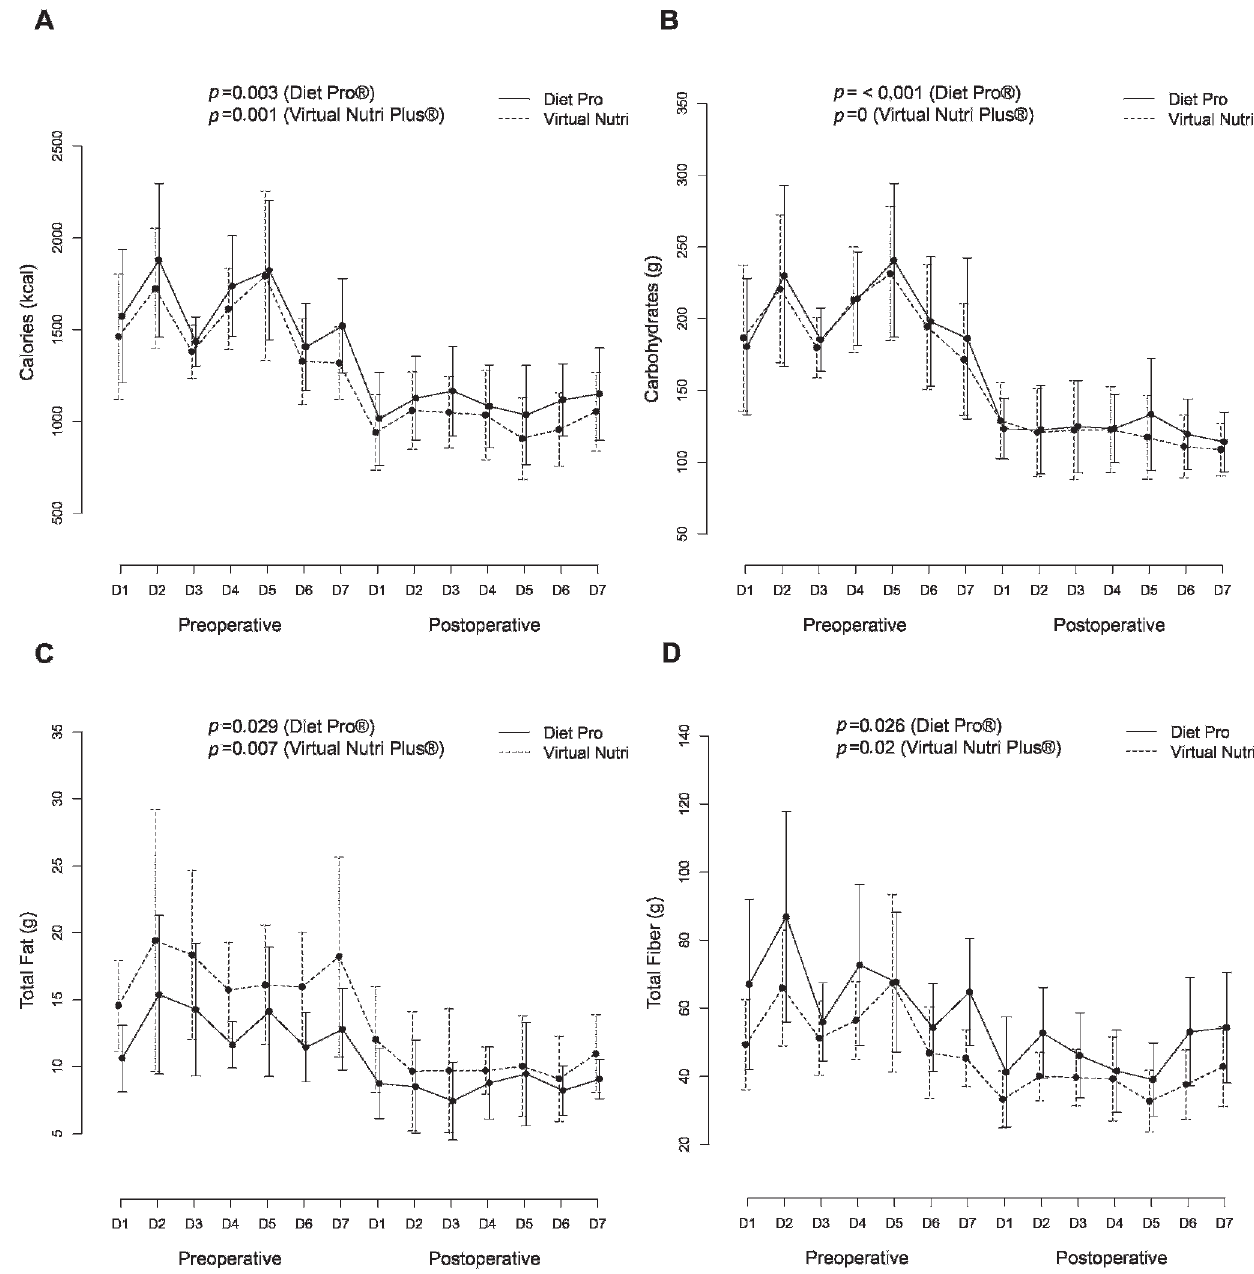
Virtual Nutri H and Dietpro 5i H software systems to estimate the nutritional content. Changes in the intake of: (A) calories, (B) carbohydrates, (C) total fat and (D)